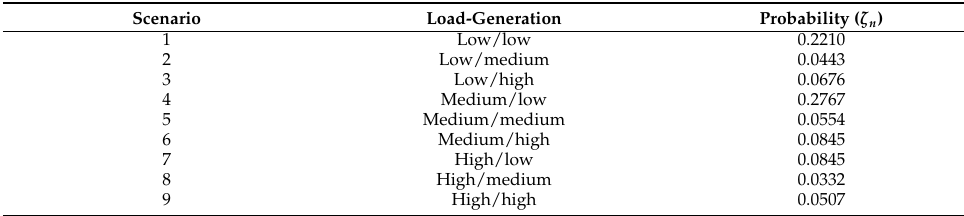
Table 2. Probability of load-generation scenarios.